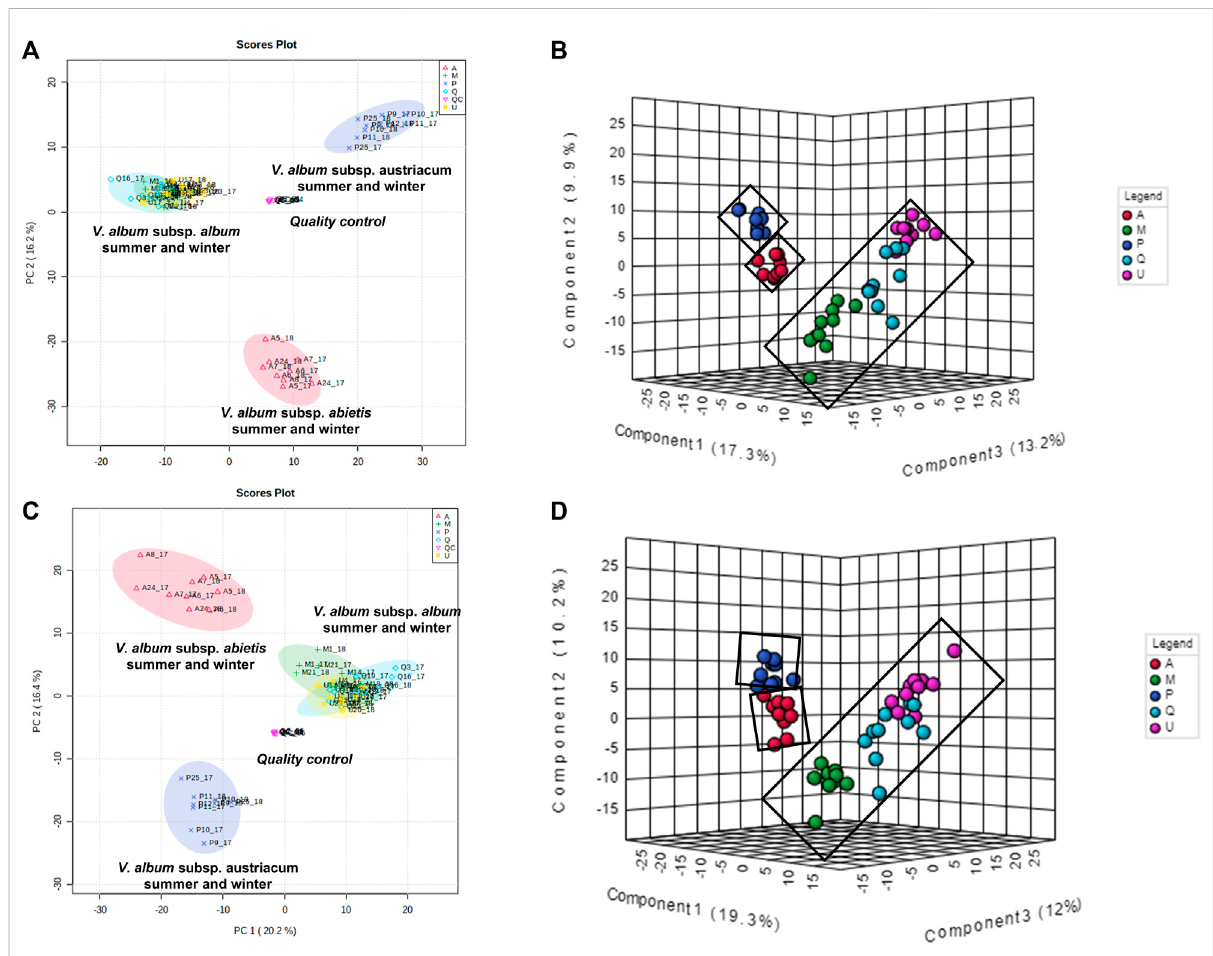
FIGURE 7 Multivariate analysis from LC-HRMS data of V. album mother tinctures. Discrimination of the samples in relation to V. album host trees. (A) PCA 2D score plot of the negative ESI mode. (B) PLS-DA 3D score plot of the negative ESI mode (C) PCA 2D score plot of the positive ESI mode. (D) PLS- DA 3D score plot of the positive ESI